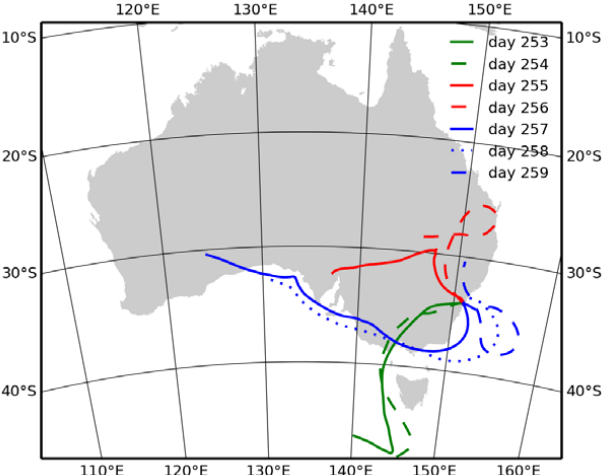
Figure 3. One week of 4-day HYSPLIT back-trajectories depicting conditions of high (red), moderate (green) and low (blue) terres- trial influence on air masses arriving at Lucas Heights, NSW. Each trajectory is the average of five hourly trajectories between 13:00– 17:00LST each